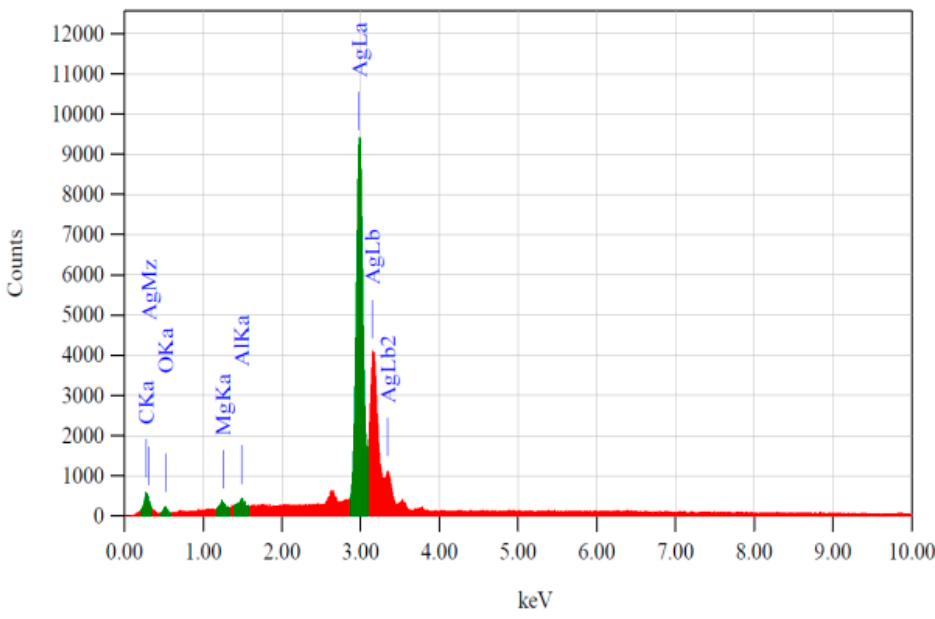
Figure 5 . A typical energy-dispersive X-ray (EDS) spectrum of the flattened Ag metal predominantly showing peaks for Ag metal: AgLa, AgLb and AgLb2 lines at 2.983, 3.151 and 3.348 keV, respectively. Traces of C, O, Mg and Al were also seen at 0.277, 0.525, 1.253, 1.486 keV, respectively. The spectra were similar for the different test samples in this study, irrespective of the chemical etching treatments with and without heating.